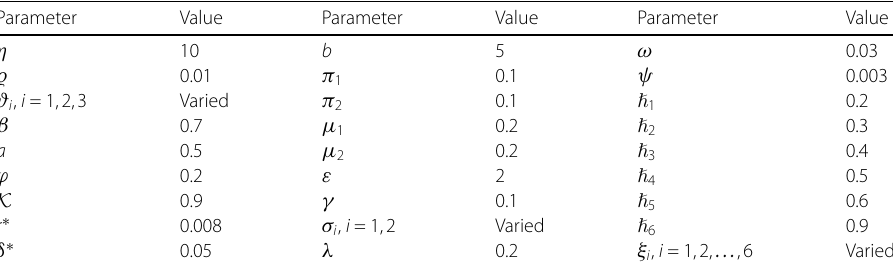
Table 1 The data of model (29)